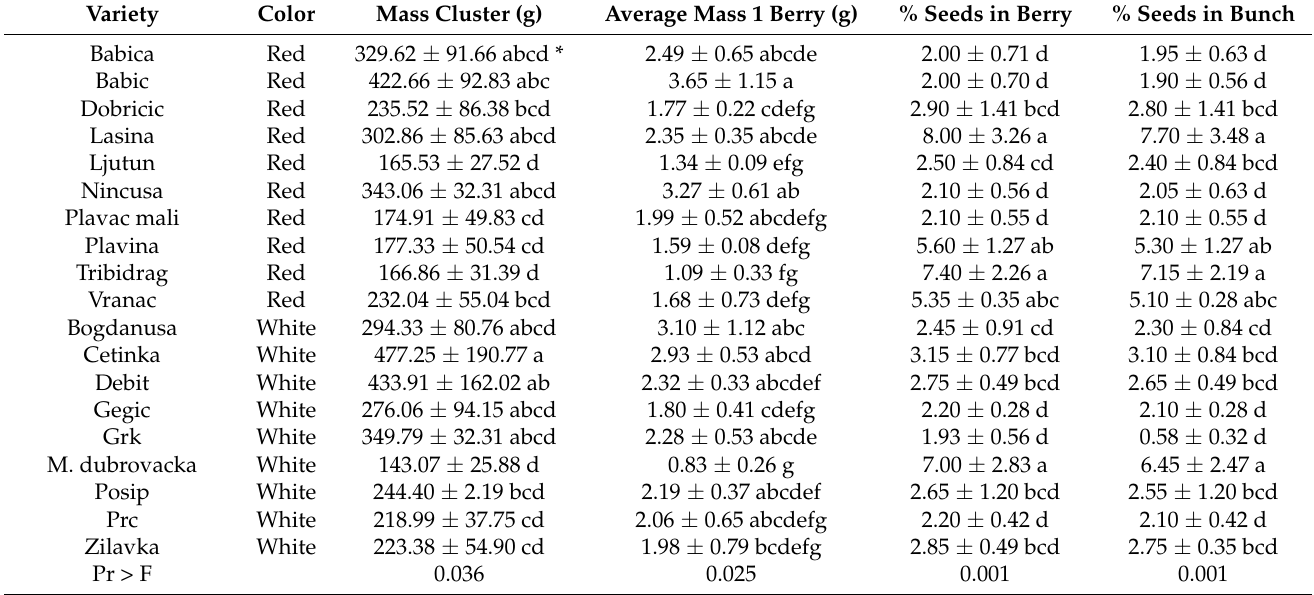
Table 2. Mean values of seed content in analyzed grape